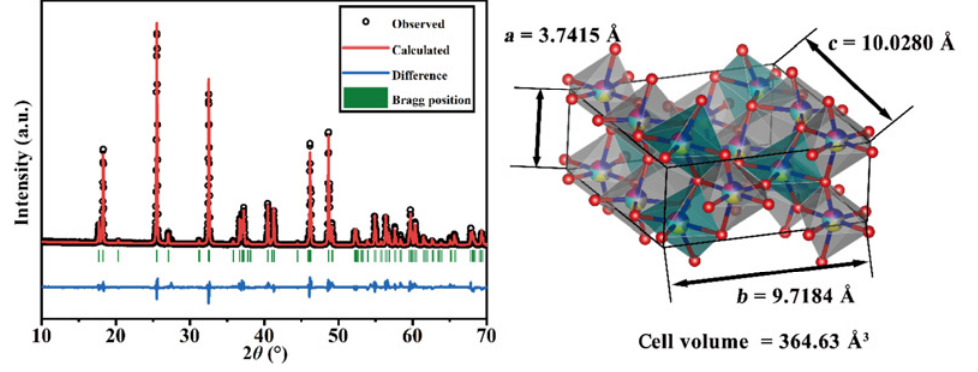
Fig. 9 Rietveld analysis of the XRD patterns.